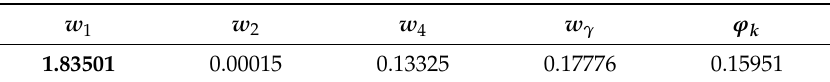
Table 4. Model coefficients of δ HS